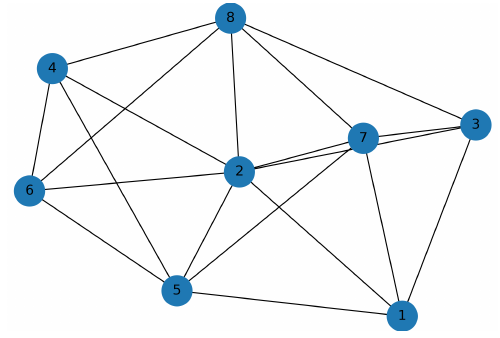
Figure 11. Clustering graph G ( V , E ) for δ =